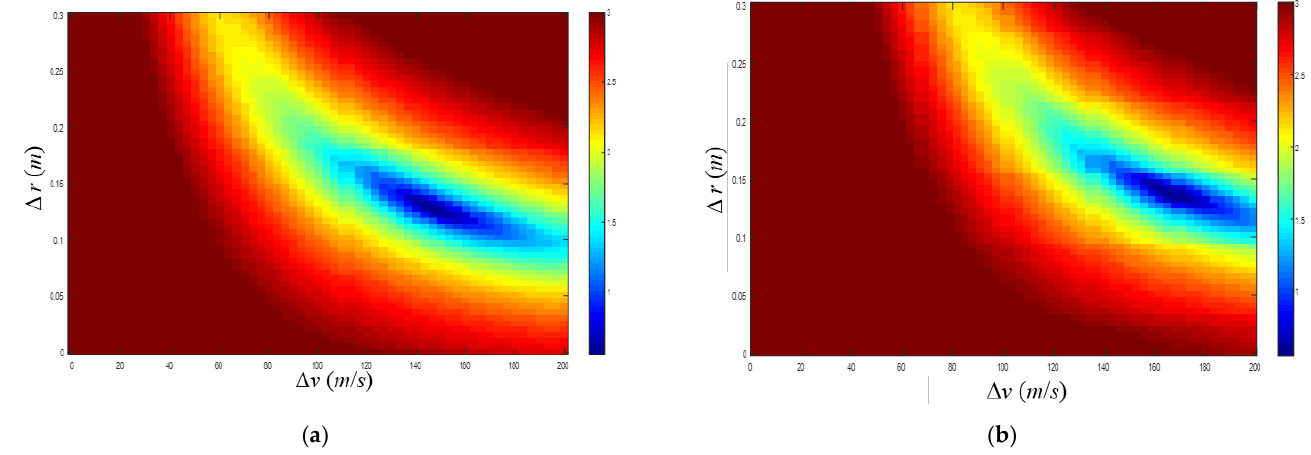
Figure 8. Two-dimensional image of objective function: ( a ) using equivalent-tool theory and ( b ) without using equivalent-tool theory.